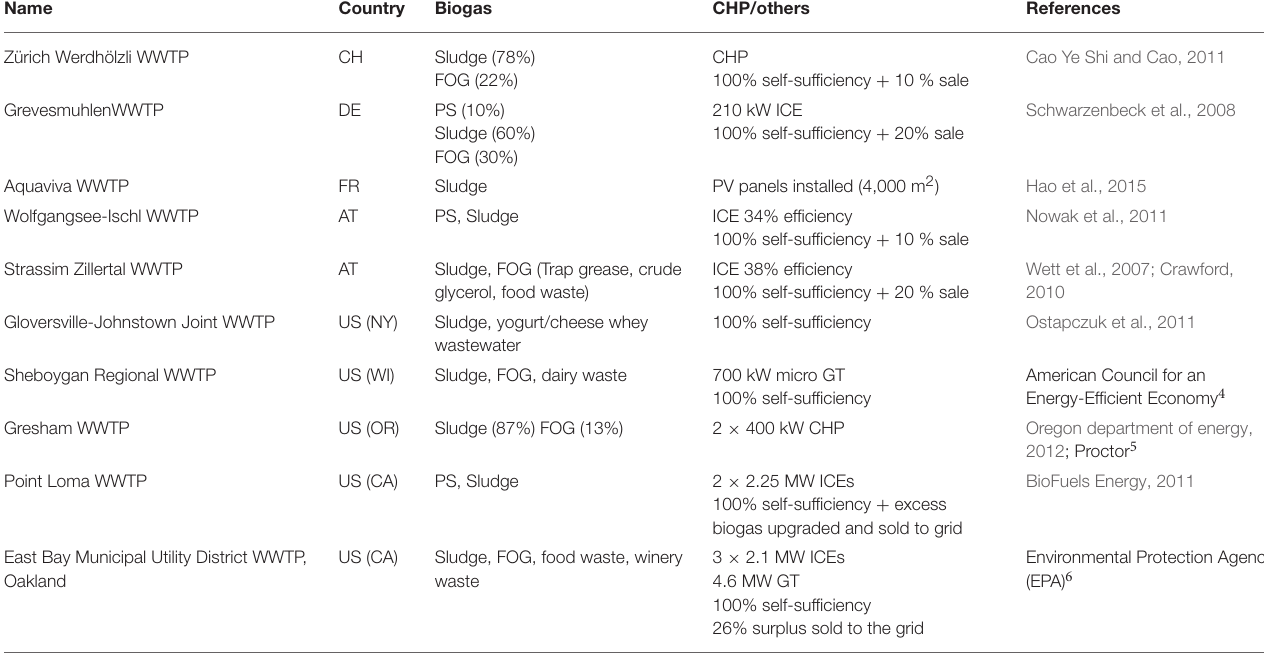
TABLE 6 | List of current self-sufficient